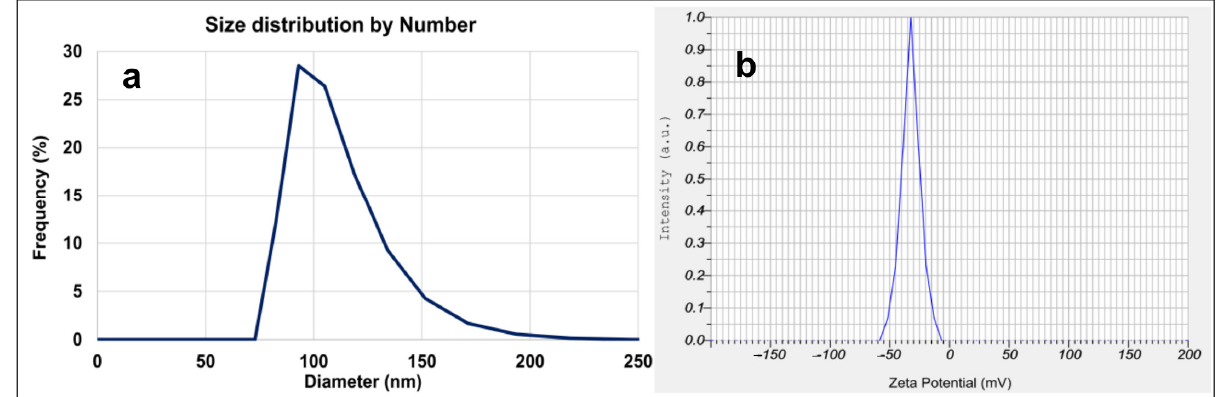
Figure 4. ( a ) Hydrodynamic particle size of CC-AuNPs using DLS (number-weighted) analysis (101.4 ± 19.6 nm), ( b ) zeta potential analysis of CC-AuNPs ( − 30.8 ± 1.5).